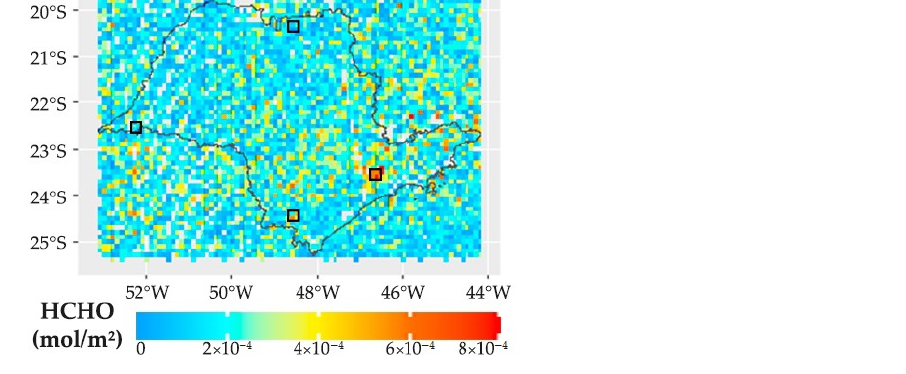
Figure 8. Vertical HCHO columns (12 p.m.–4 p.m. local time) over São Paulo State on 12 March. The black squares indicate the locations of the four areas of interest shown in Figure 2.